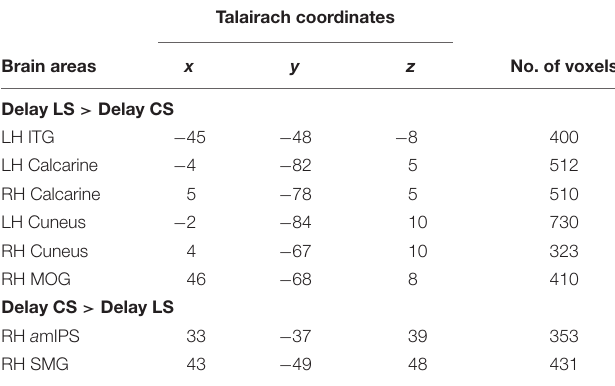
TABLE 3 | Talairach coordinates and number of voxels for contrast no. 2.